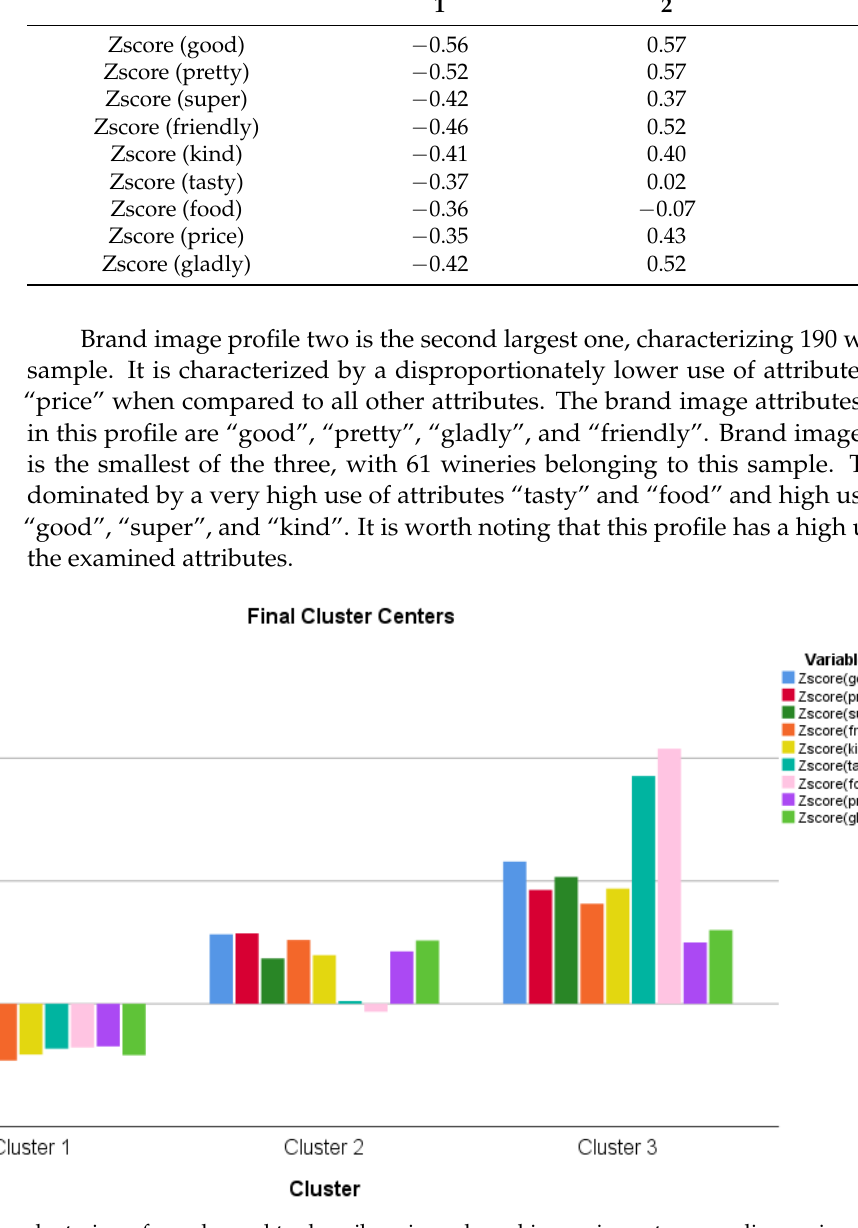
Figure 4. K-means clustering of words used to describe winery brand image in customer online reviews.